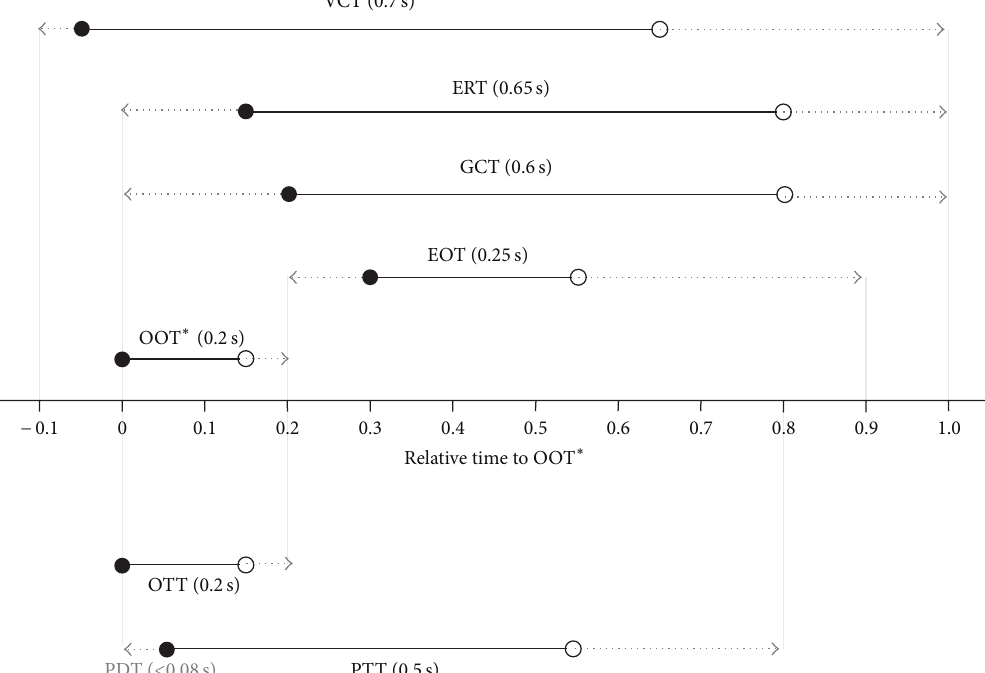
Figure 5: Temporal pattern of physiological events during normal swallowing. VCT: velo-pharyngeal closure, ERT: epiglottic retroflexion, GCT: glottal closure, EOT: esophageal opening, OOT: oro-velar opening (start time defined as reference), OTT: oro-velar transit, PDT: pharyngeal delay, and PTT: pharyngeal transit. Solid lines indicate durations with mean values in brackets (10 subjects), while circles represent respective start (solid) and end times (open). Arrows refer to maximal